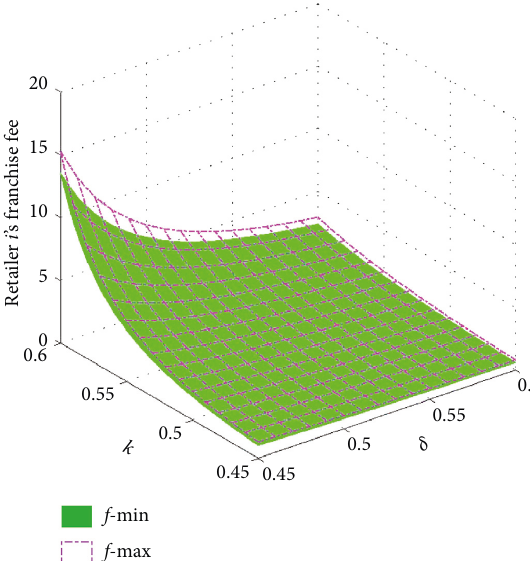
Figure 10: Feasible lower and upper bounds of franchise fees vs. k and δ in the ( R